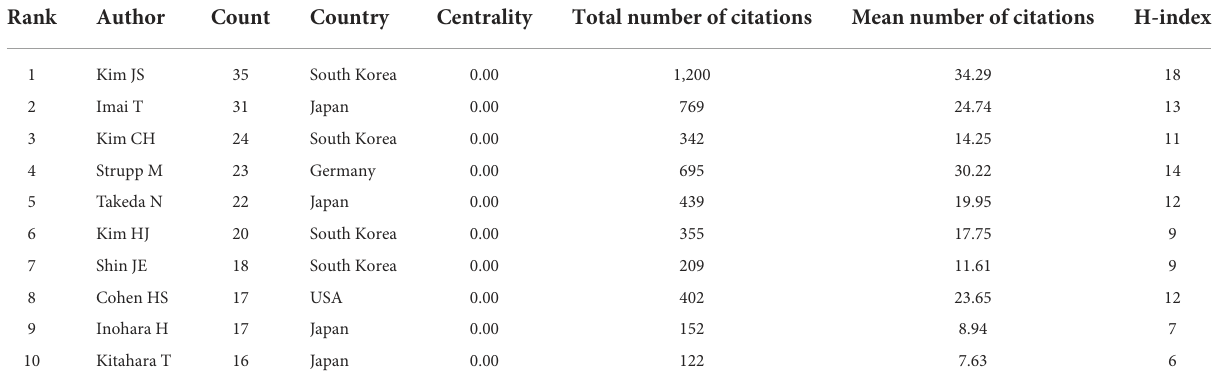
TABLE 3 The top-10 authors with the most publications related to BPPV.